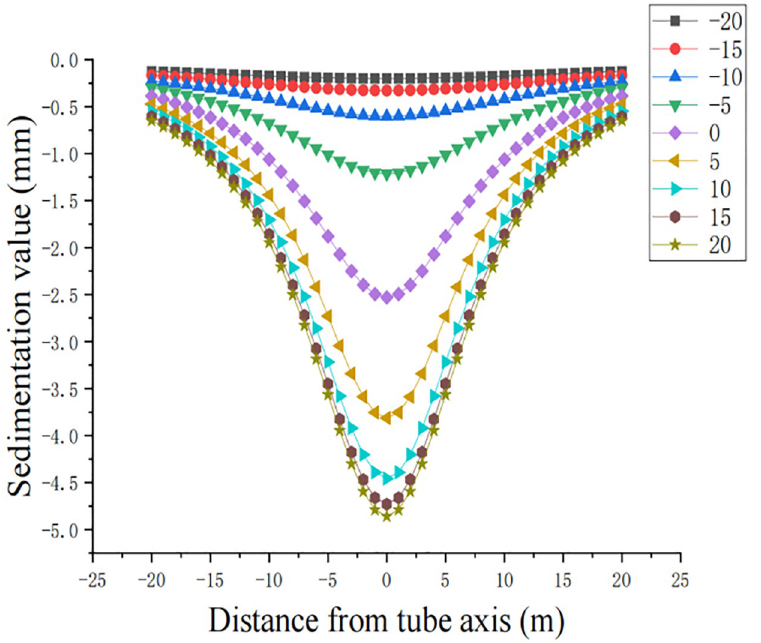
Fig 4. Soil settlement curve from the excavation surface to different